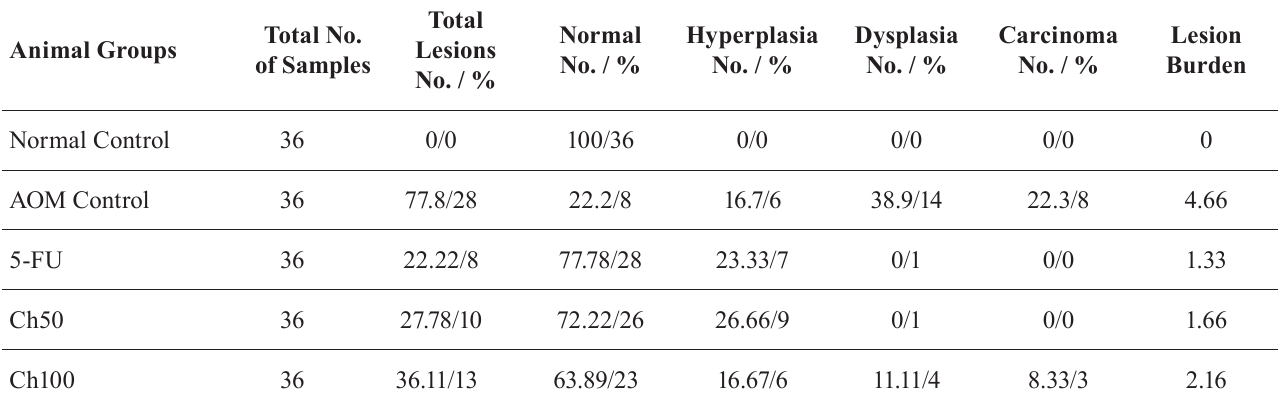
TABLE I - T he effects of 5-FU and chrysin and their combined treatments on histopathologic indexes of the colon tissue in mice receiving